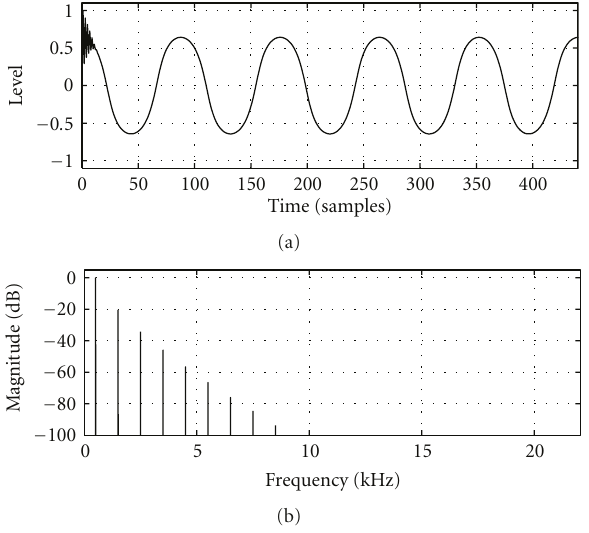
Figure 16: FBAM variation 4 with ABS waveshaping ( β = 1, f 0 = 500Hz), see Figure